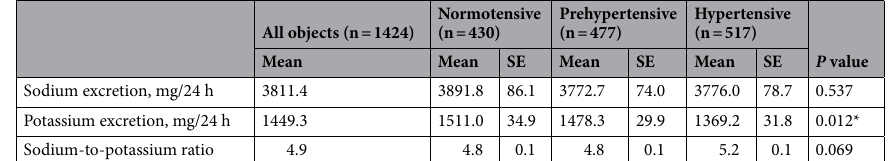
Table 2. Estimated mean 24-h urinary sodium and potassium excretion and their ratio among participants. Estimated means of usual excretion were adjusted for age, sex, ethnicity, and body mass index. F tests in 24-h urinary potassium excretion and sodium-to-potassium ratio by hypertensive status were significant. The ratio of sodium-to-potassium was expressed as a molar ratio. SE, standard error. * P < 0.05.